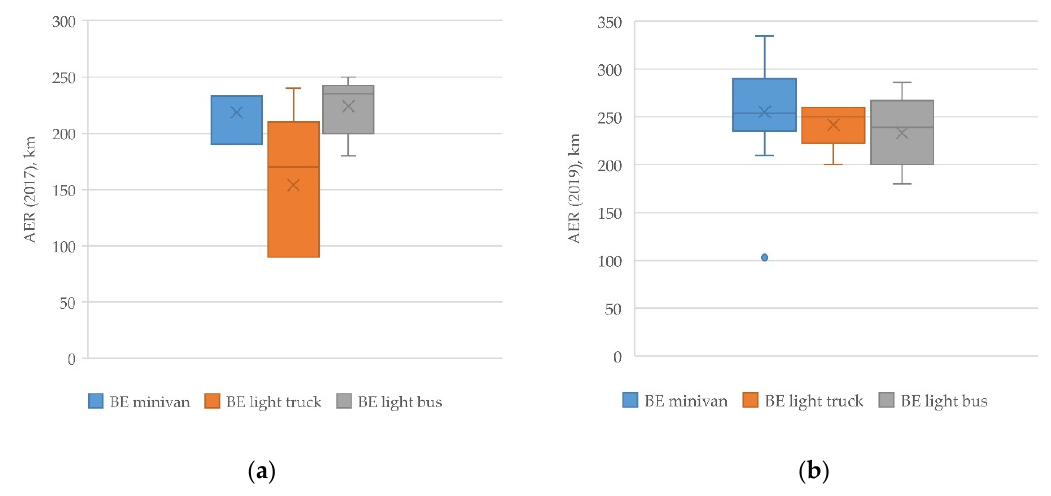
Figure 8. All-electric range (AER) distribution of the various BELVs, ( a ) 2017 and ( b ) 2019.